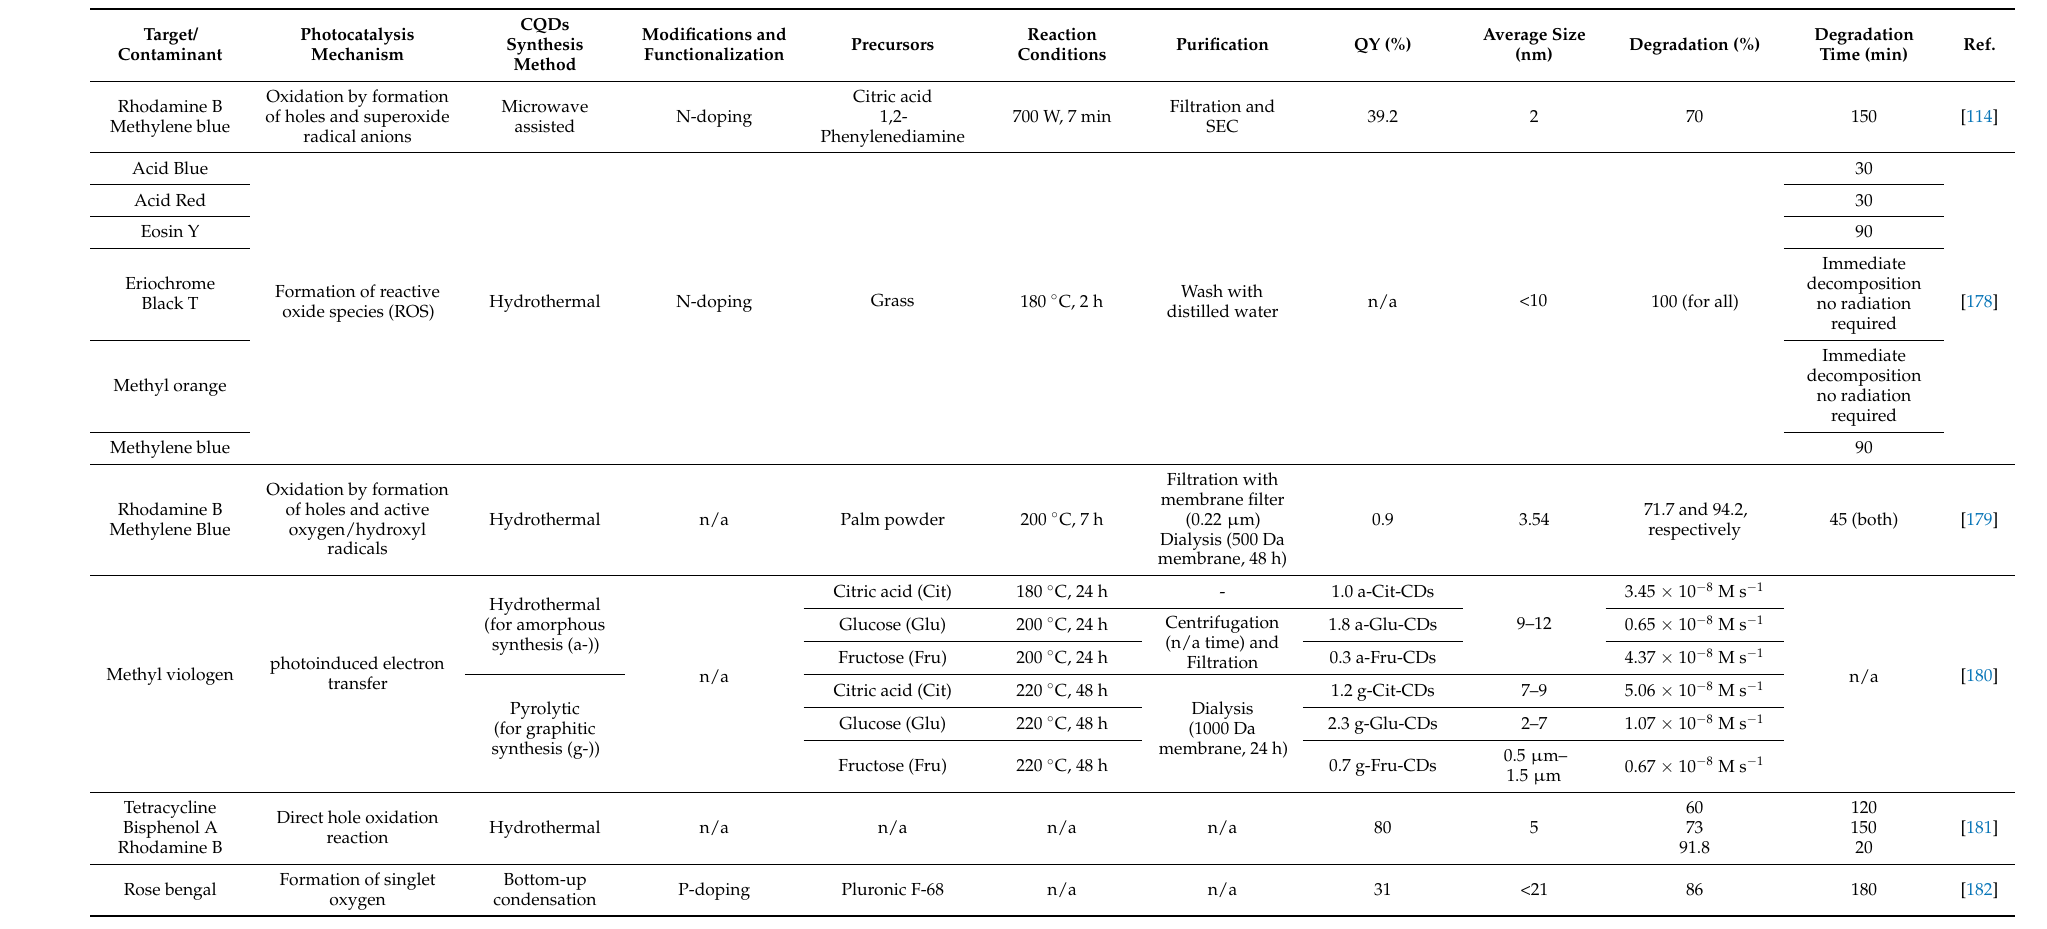
Table 6. Summarized examples of carbon quantum dots used for